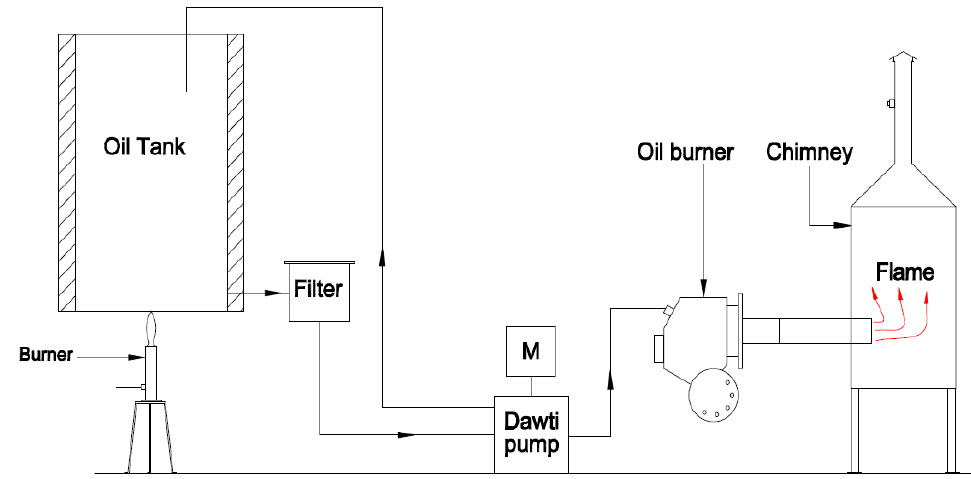
Figure 13. A burner assembly that can be used for combustion of upgraded bio-oil to generate heat.